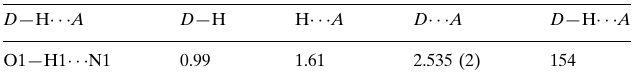
Hydrogen-bond geometry (A˚ , (cid:2)